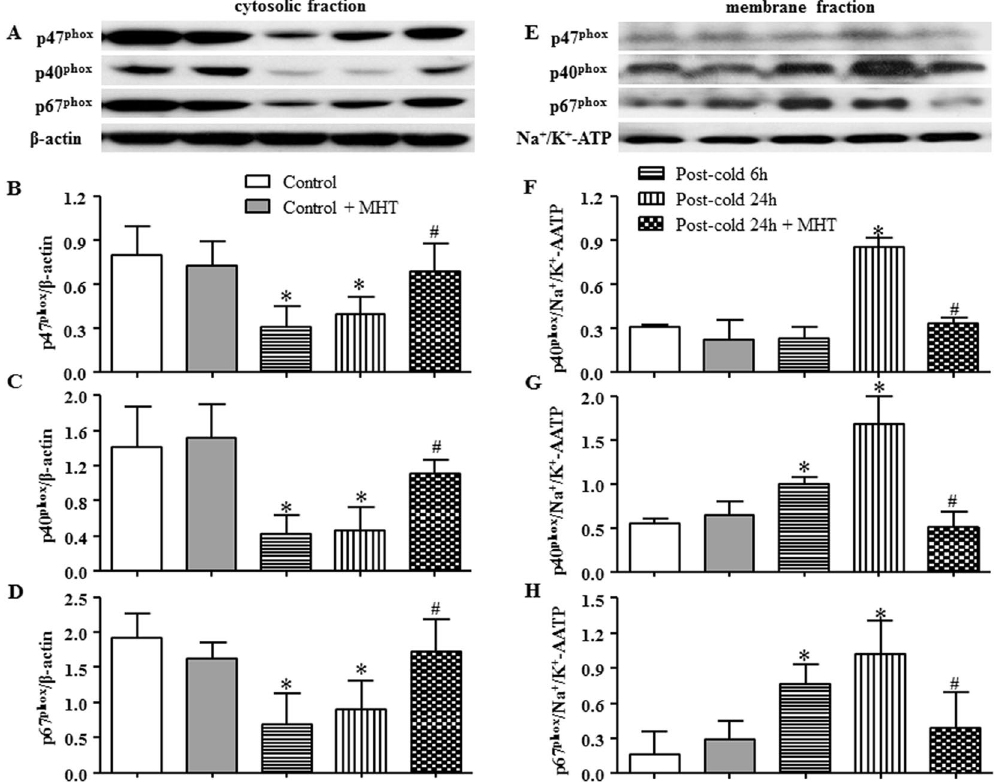
Figure 8. Effect of MHT post-treatment on membrane translocation of NADPH oxidase subunits p47 phox , p40 phox and p67 phox . ( A,E ) The representative western blot bands of NADPH oxidase subunits p47 phox , p40 phox and p67 phox in cytosolic fraction and membrane fraction, respectively; ( B ) Quantification of p47 phox in cytosol; ( C ) Quantification of p40 phox in cytosol; ( D ) Quantification of p67 phox in cytosol; ( F ) Quantification of p47 phox in cell membrane; ( G ) Quantification of p40 phox in cell membrane; ( H ) Quantification of p67 phox in cell membrane; N = 4. Results are presented as mean ± SE. * P < 0.05 vs. Control group; # P < 0.05 vs. Post-cold 24 h